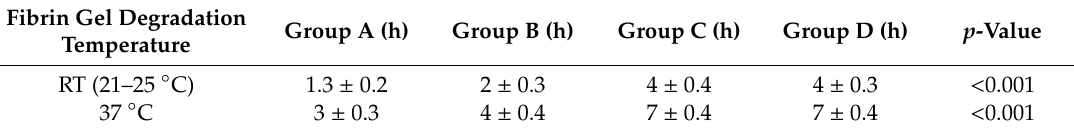
Figure 3. Characteristics of fibrin gel development. ( A ) Fibrin gel obtained from group A (A1, A5), group B (A2, A6), group C (A3, A7) and group D (A4, A8). ( B ) Time needed for the development of fibrin gel derived from all groups. ( C ) Fibrin gel area obtained from all groups. Statistically significant differences were observed in fibrin gel area between all groups ( p < 0.001). Table 4. Fibrin gel stability time at 25 °C and 37 °C. Statistically significant differences in fibrin gel